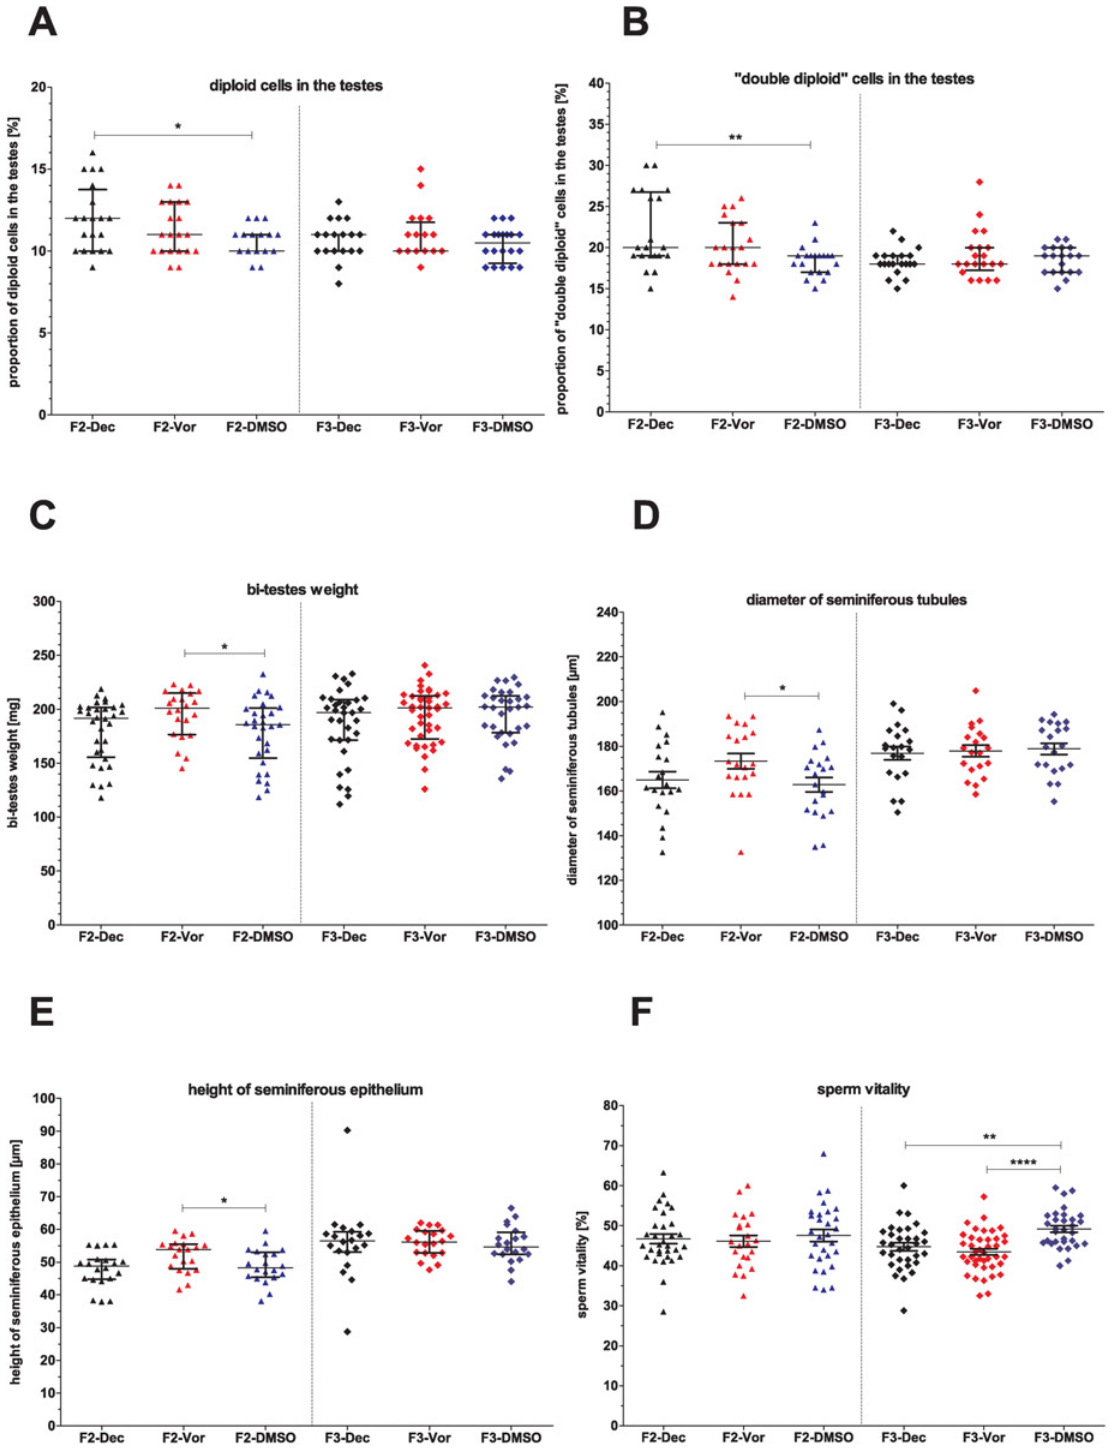
Fig 6. Transgenerational effects of decitabine and vorinostat treatment on reproductive organs and semen parameters. A) Percentage of diploid cells (undifferentiated germ cells and somatic cells) and B) of “ double diploid ” cells (spermatocytes) in the testes, C) Bi-testes weight, D) diameter of seminiferous tubules, E) height of seminiferous epithelium, F) sperm vitality. One point represents one animal. A) — C), E) The median ( ± interquartile range) or D), F) the mean ( ± SEM) are shown, * : p < 0.05, ** : p < 0.01, *** : p < 0.001, **** : p < 0.0001.